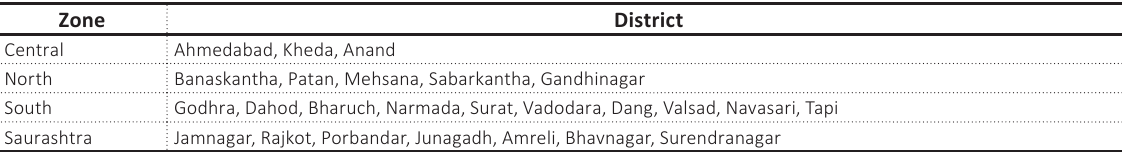
Source: Gujarat State Portal.